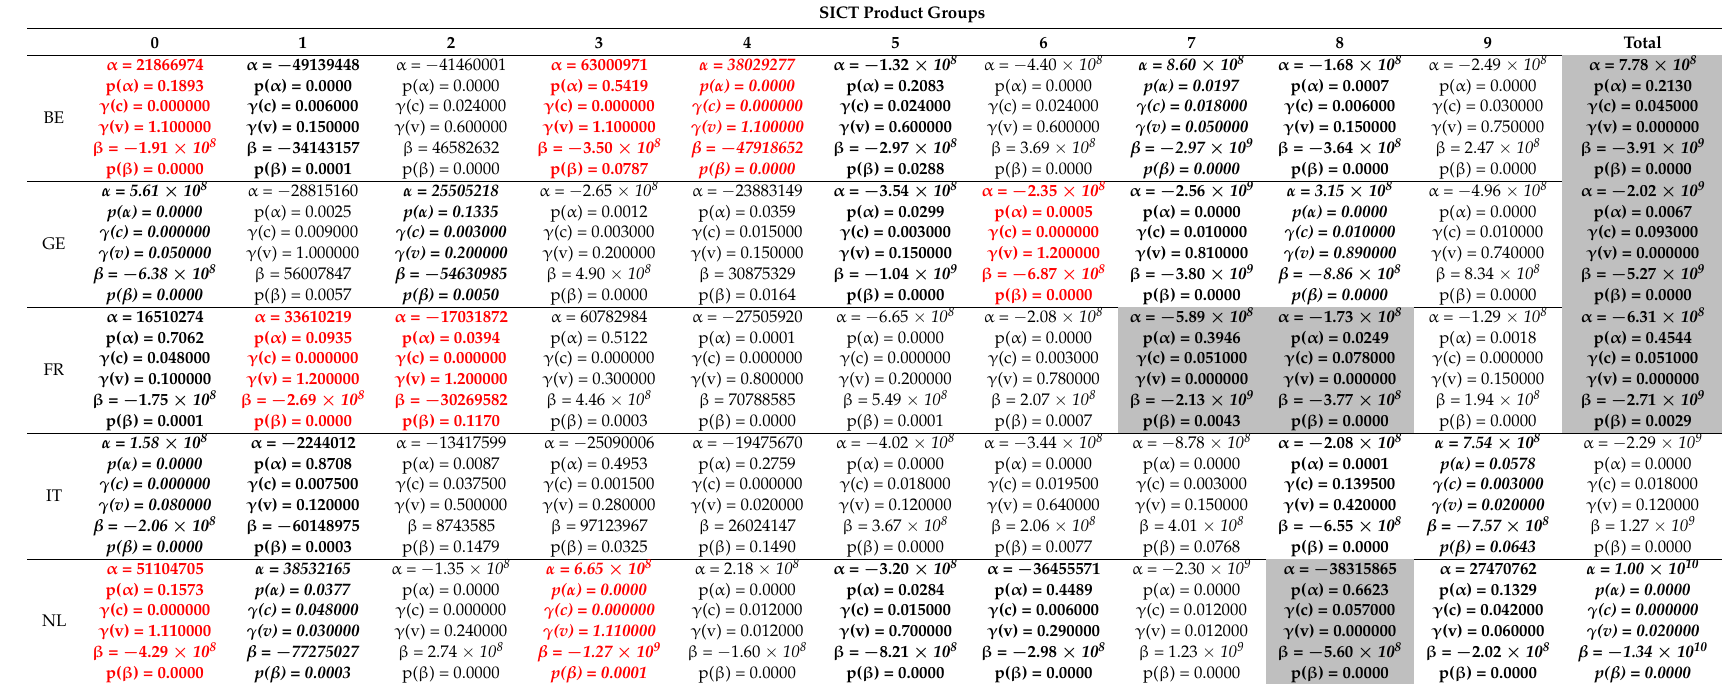
Table A5. Hysteresis with a variable play area (TED